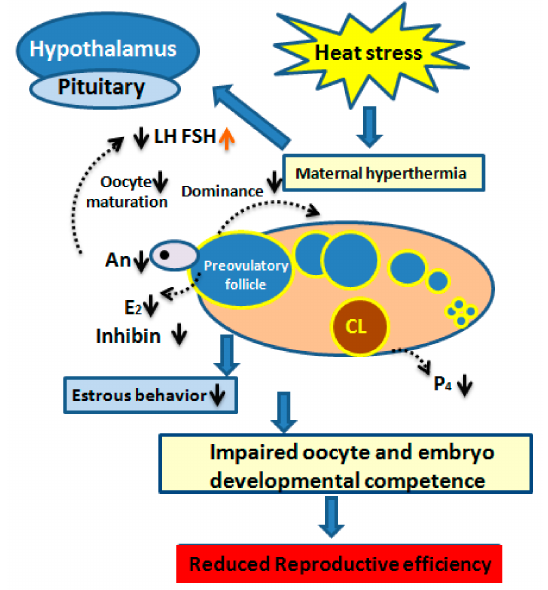
Figure 3. Diagram elucidating the interaction between the impact of seasonal heat stress and the hypothalamus–pituitary–ovarian axis and its mechanism of a ff ecting dairy cow fertility. The lower luteinizinghormone(LH)surgeisrelatedtoadecreasedsecretionoffollicularestradiol(E2). Lowerlevels of androstenedione (An) and E2 levels are responsible for decreasing the dominance of preovulatory follicle and is related to poor estrous behavior. Likewise, impaired concentrations of follicle-stimulating hormone (FSH) and inhibin are related to the increased number of medium-sized follicles. Impaired competence of maturing oocyte and developing embryo is due to the disturbed nuclear and cytoplasmic maturation. Reduced reproductive e ffi ciency in dairy cows is the ultimate outcome of heat